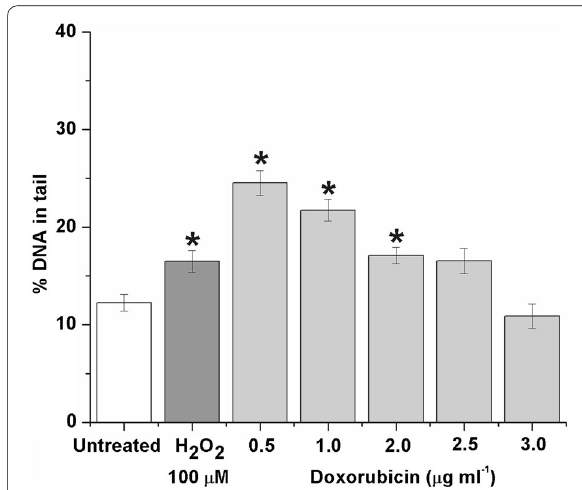
Fig. 2 % DNA in tail in HL-60 comets after treatment with various concentrations of doxorubicin. H 2 O 2 (100 μM) was used as positive control. DNA was stained with ethidium bromide. * p comparison with control (one-way ANOVA). Bars represent standard error